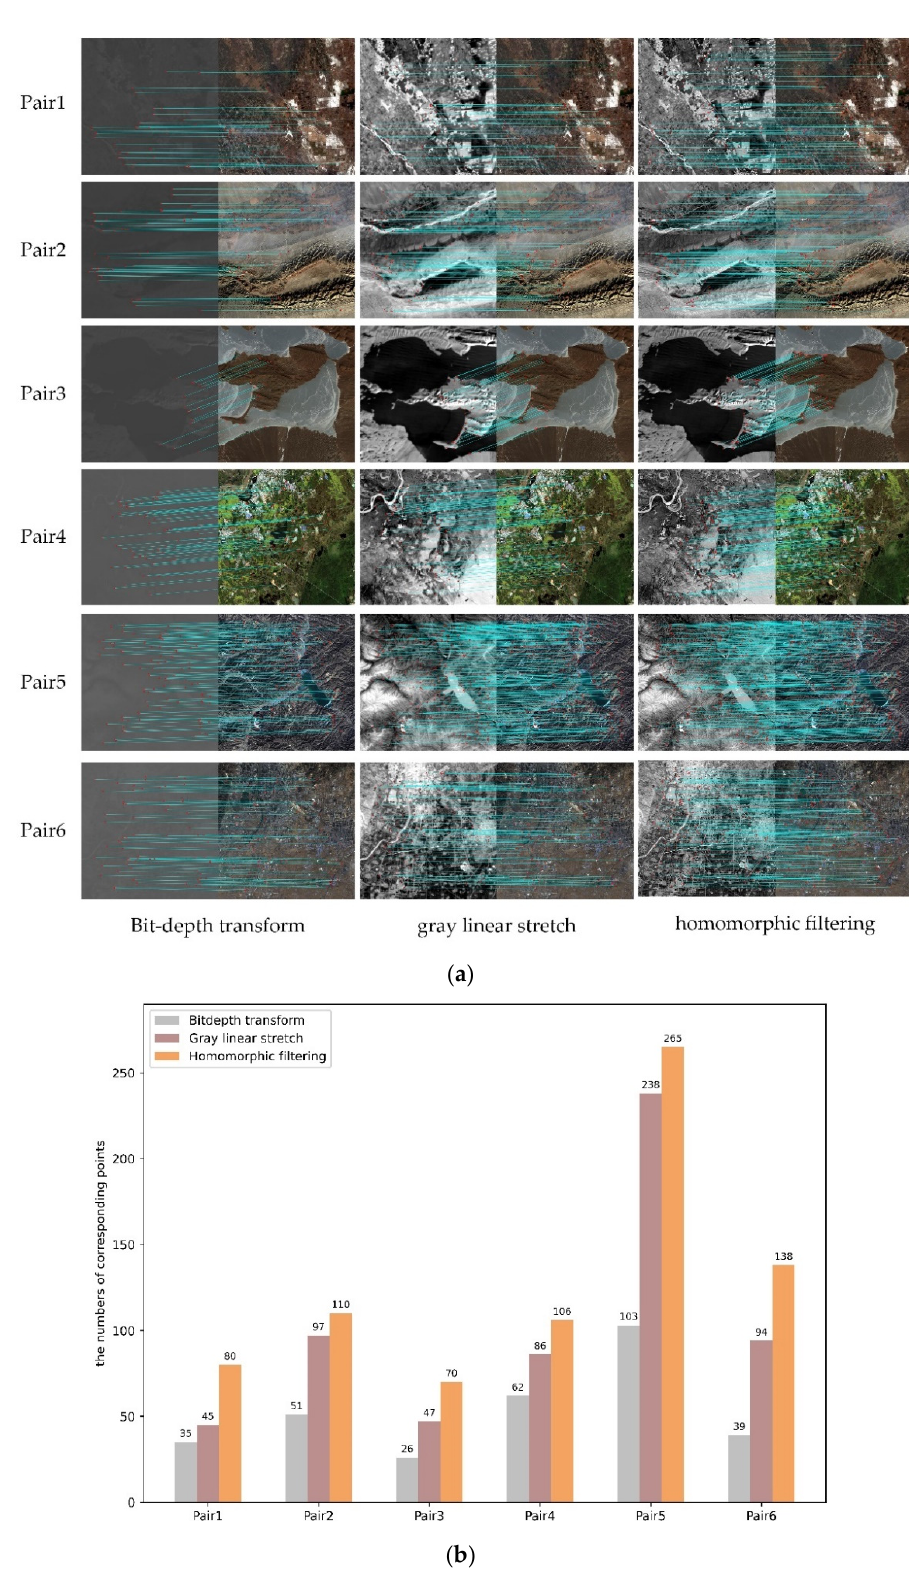
Figure 10. The contrast test for three gray transformation methods. ( a ) The registration result by using the modified RIFT with three different gray transformation. ( b ) The numbers of the correct corresponding points of the registration.